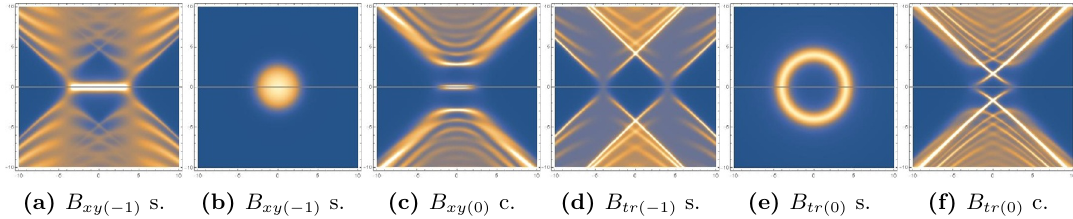
Figure 11. Spectral function with various types tensor interaction, which is decomposed into 2+1 radial vector B µr ’s (ab) and 2-tensor B xy (cd). Notice the zero mode Disk in B xy . There are rotational symmetry in B tr , B xy .